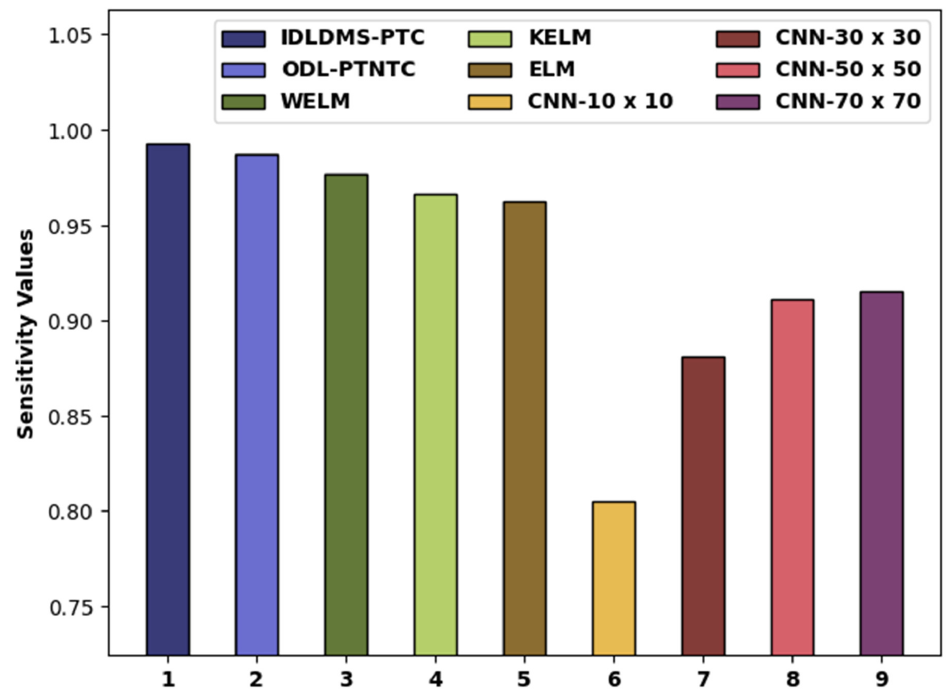
Figure 9. Sens y analysis of IDLDMS-PTC technique compared with recent approaches. Figure 9.   analysis of IDLDMS-PTC technique compared with recent approaches. Table 3. Comparative analysis of IDLDMS-PTC technique with recent approaches.